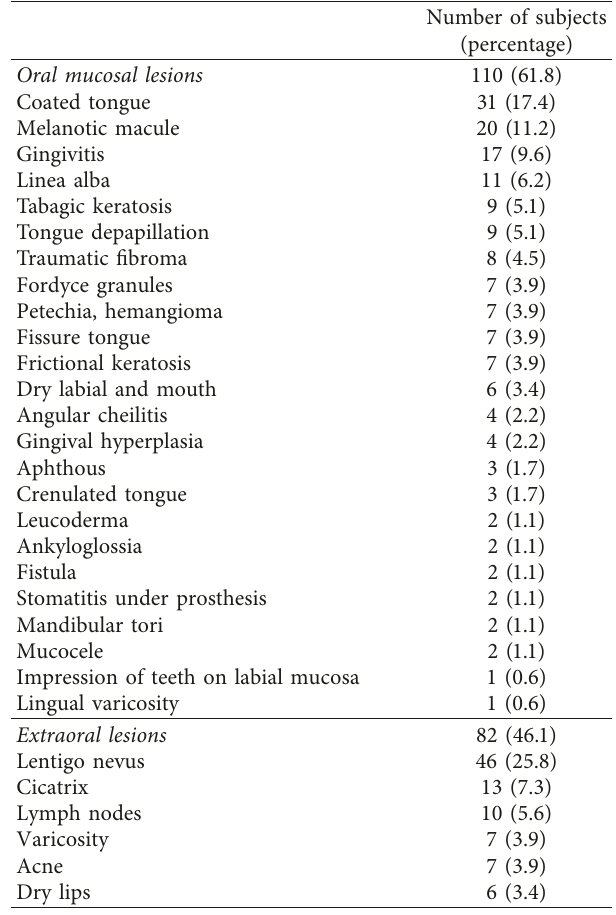
Table 4: Lesion findings on intraoral and extraoral examinations ( n � 178).